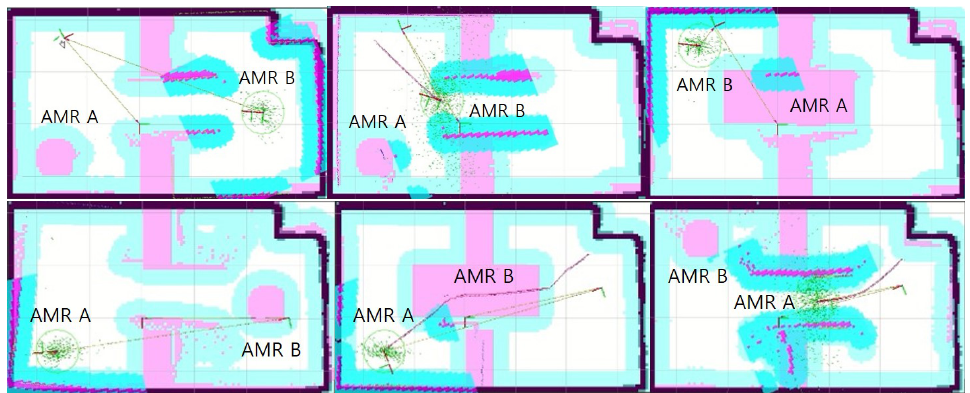
Figure 11. The cost maps of AMR B and A in the narrow path under the region filter.